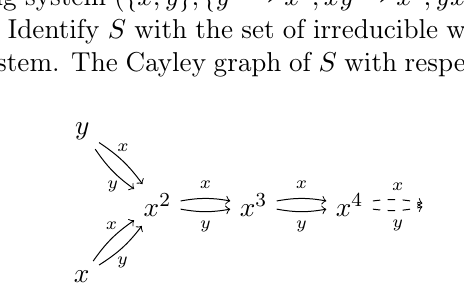
Fig. 1. The Cayley graph of the semigroup S from Example 4.1 with respect to the generating set t x, y u